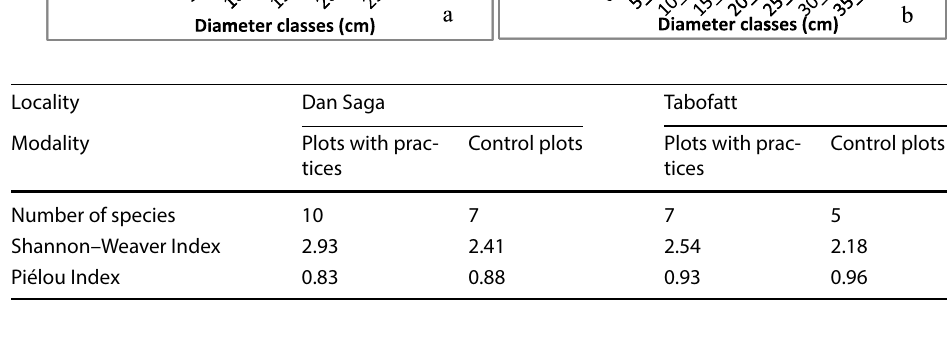
Table 4 Results of Sorensen Index analysis